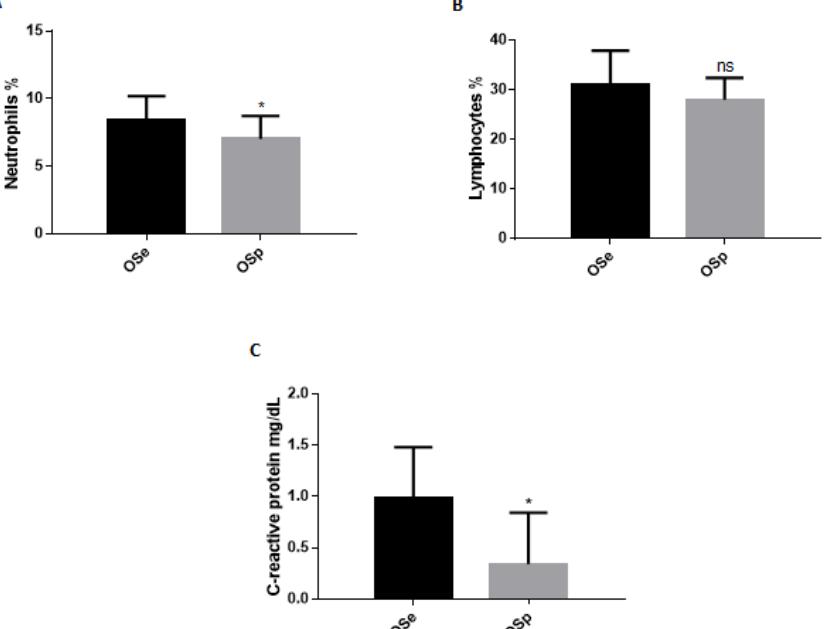
Figure 1. White blood cells and C-reactive protein in sedentary obese children (OSe) compared to obese children who played sport (OSp). ( A ) Neutrophils, ( B ) Lymphocytes, ( C ) C-reactive protein. The data are expressed as the means ± SDs. The significance was determined by the Student’s t -test: * ( p < 0.05), which represents significance compared to sedentary obese children, ns ( p > 0.05), not significative compared to sedentary obese children.